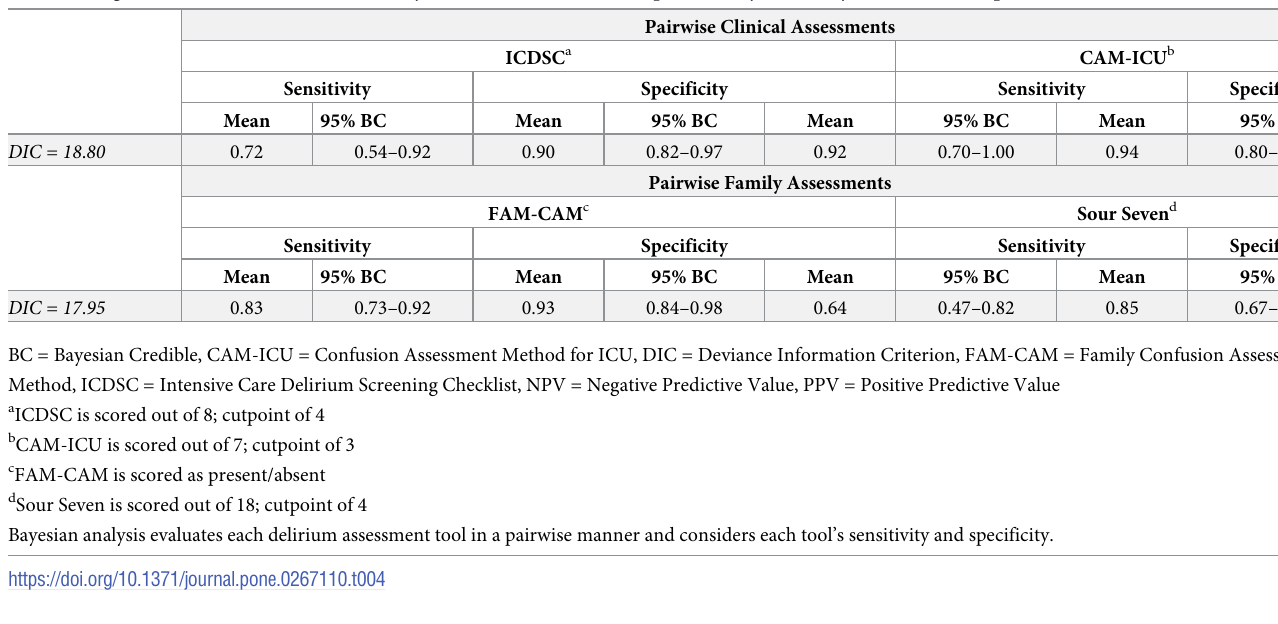
Table 4. Diagnostic criteria for clinical and family delirium assessments from pairwise Bayesian analyses for whole sample ( n =